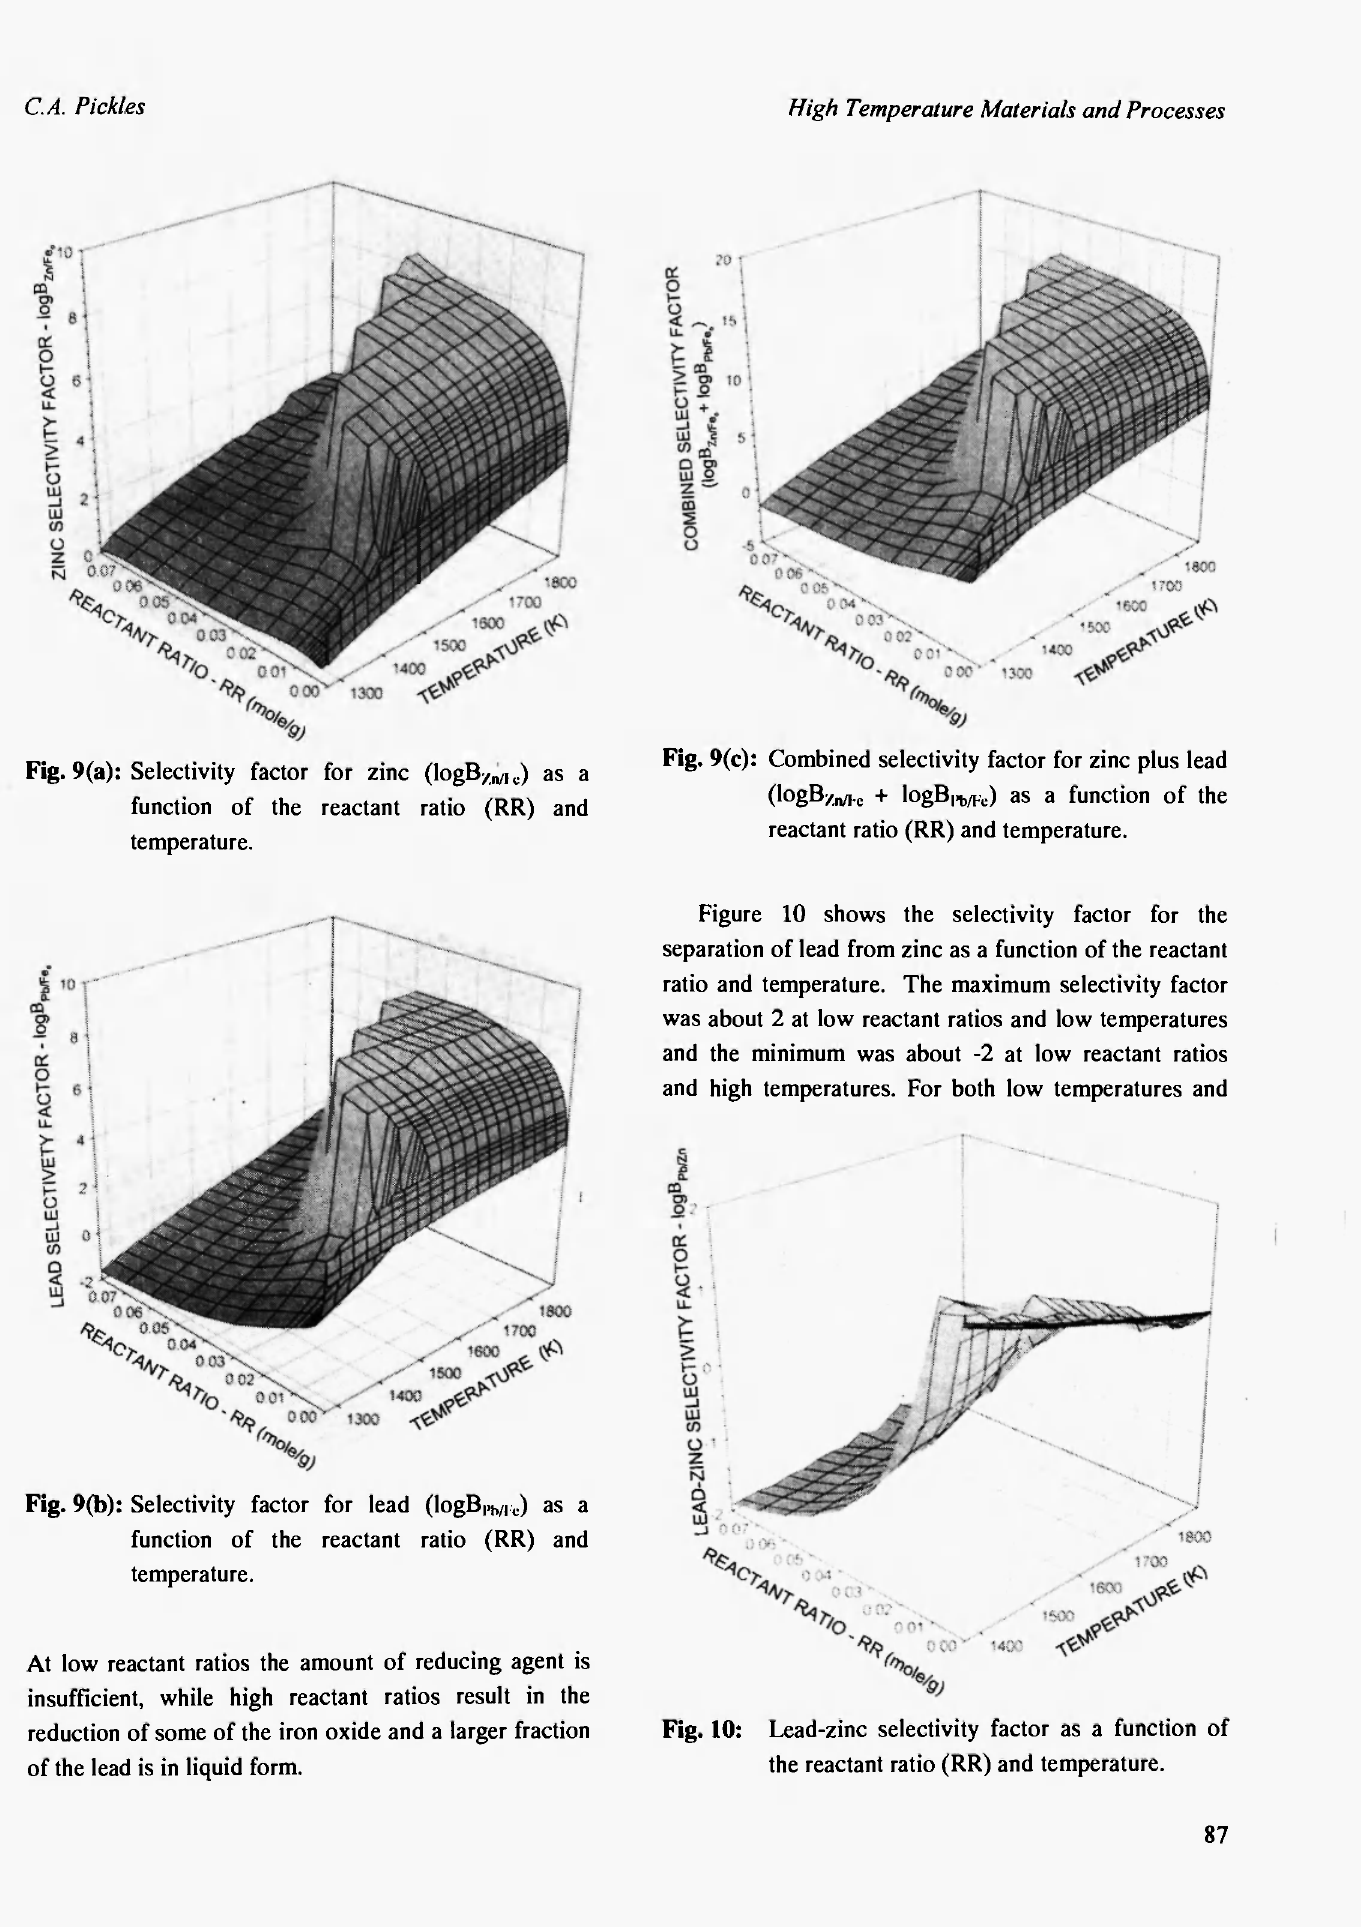
Fig. 9(b): Selectivity factor for lead (logBpM*) as a function of the reactant ratio (RR) and temperature.